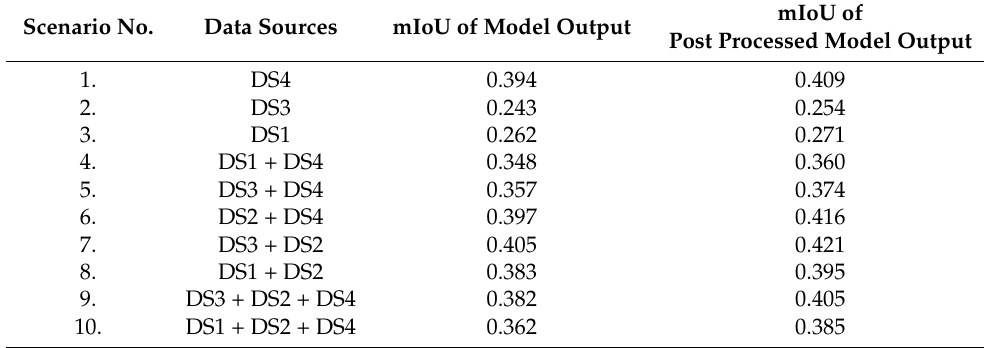
Table 5. The mIoU value for the model output and post-processed model output. Scenario No.